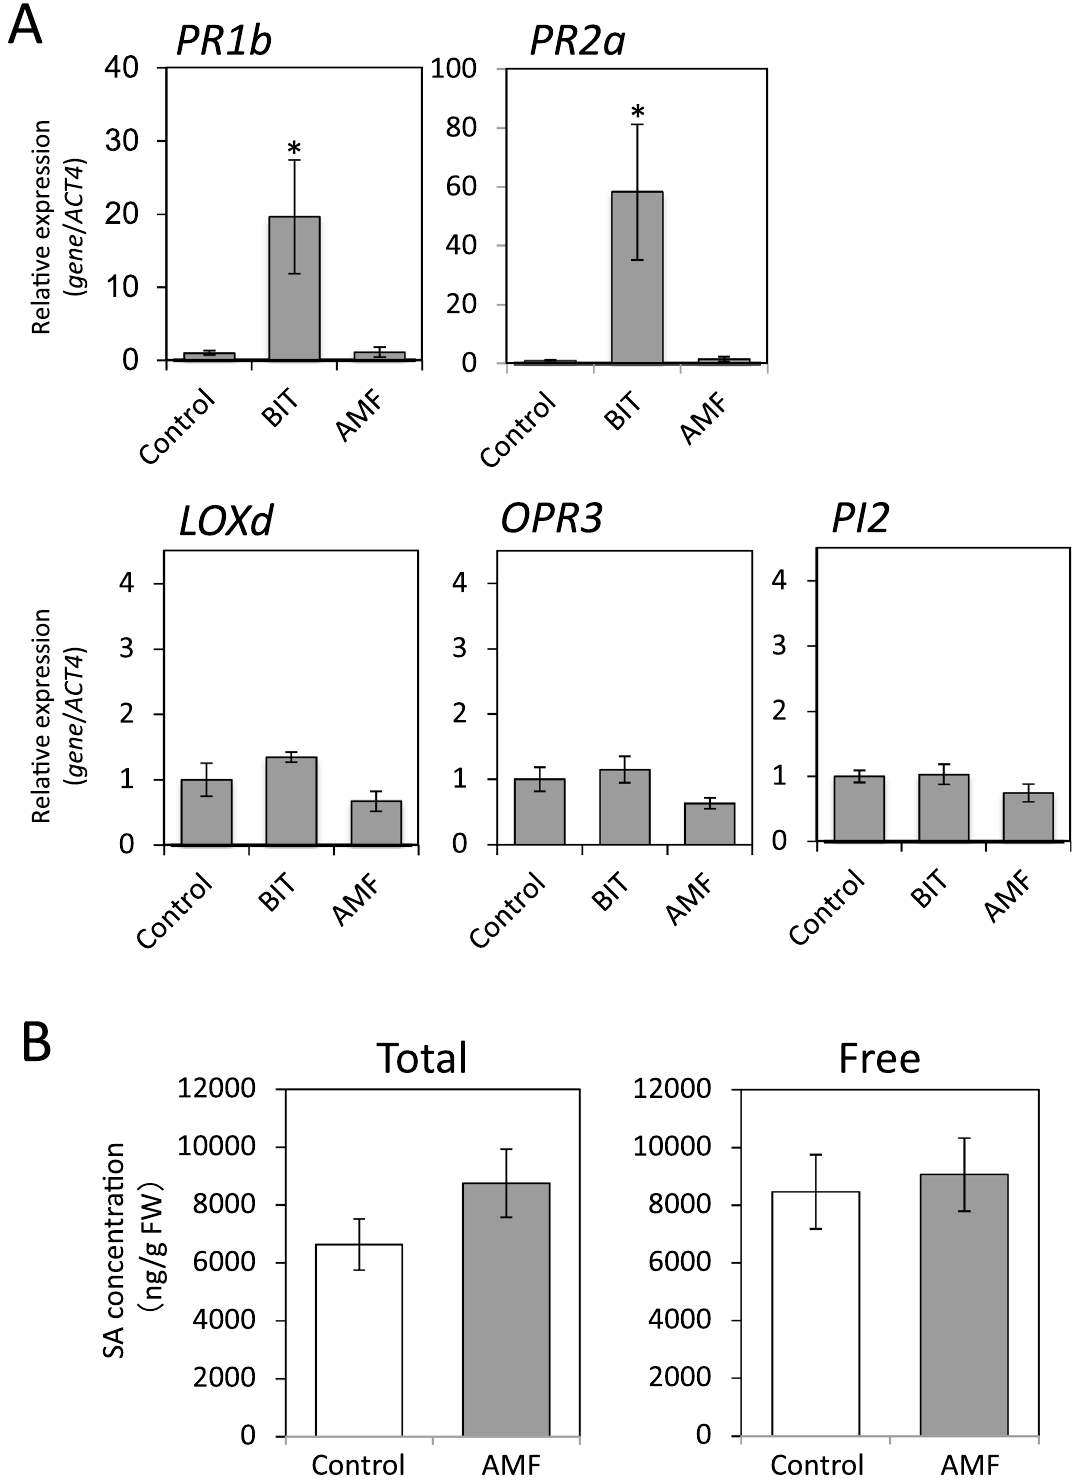
Figure 2. ( A ) Expression of defense-related genes in G. margarita -colonized tomato plants. Terminal leaflets of the 4th compound leaves were collected 14 days after the inoculation with G. margarita (AMF). SAR was induced by treatment with BIT (5 mg/pot) by soil drenching for 5 days. Real time PCR analysis was performed to evaluate the expression of SAR marker genes ( PR1b and PR2a ) and JA-related genes ( Loxd , OPR3 and PI2 ). Transcript levels were normalized to the expression of ACT4 measured in the same samples. The means and SEs were calculated from 4 independent samples, each taken from a single plant. Asterisk indicates statistically significant difference between data of the control and BIT-treated plants (two-sided t-test, p < 0.05). The experiment was repeated three times with similar results. ( B ) Salicylic acid levels in G. margarita -colonized plants. Terminal and its neighboring leaflets of 4th compound leaves were harvested at 14 days after inoculation with G. margarita (25 spores/pot) (AMF). The levels of free and total SA (free SA + SA-glucoside) were quantified by HPLC. Values presented are the means ± SE from 6 samples, each prepared from a single plant. The experiment was repeated three times with similar